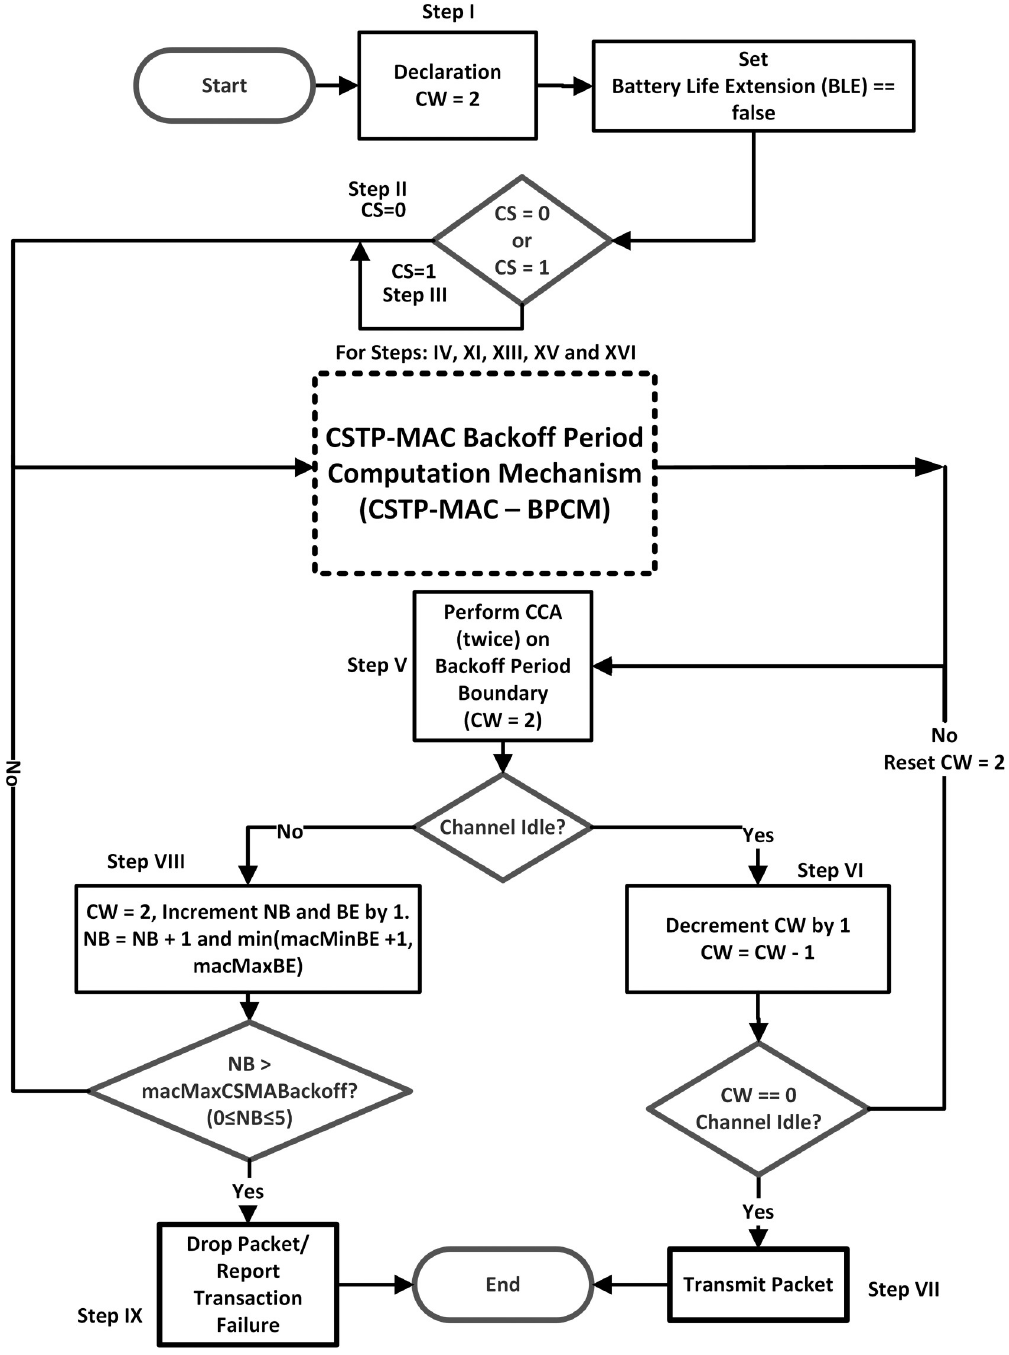
Fig 7. CSTP-MAC flowchart for slotted